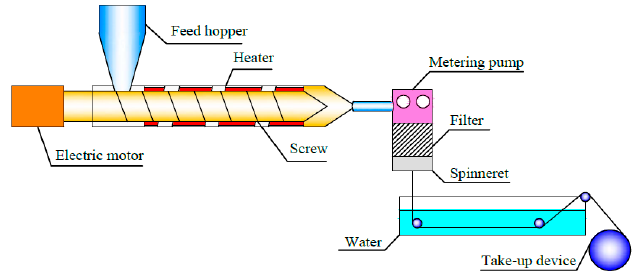
Figure 1. Spinning device diagram of poly(ether ether ketone) (PEEK) / polyetherimide (PEI) blend hollow fibers.